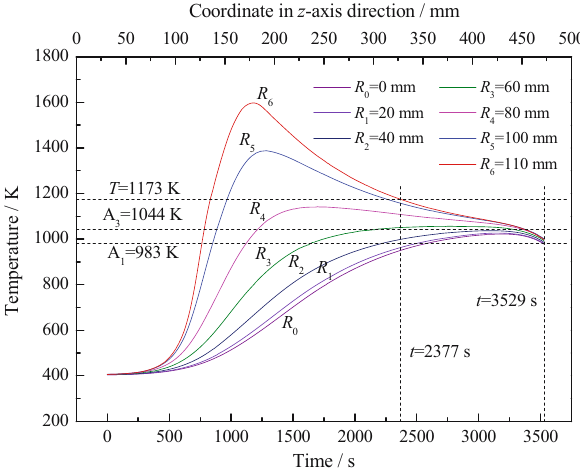
Figure 3: Temperature varying with coordinate and time at different radial positions of roll